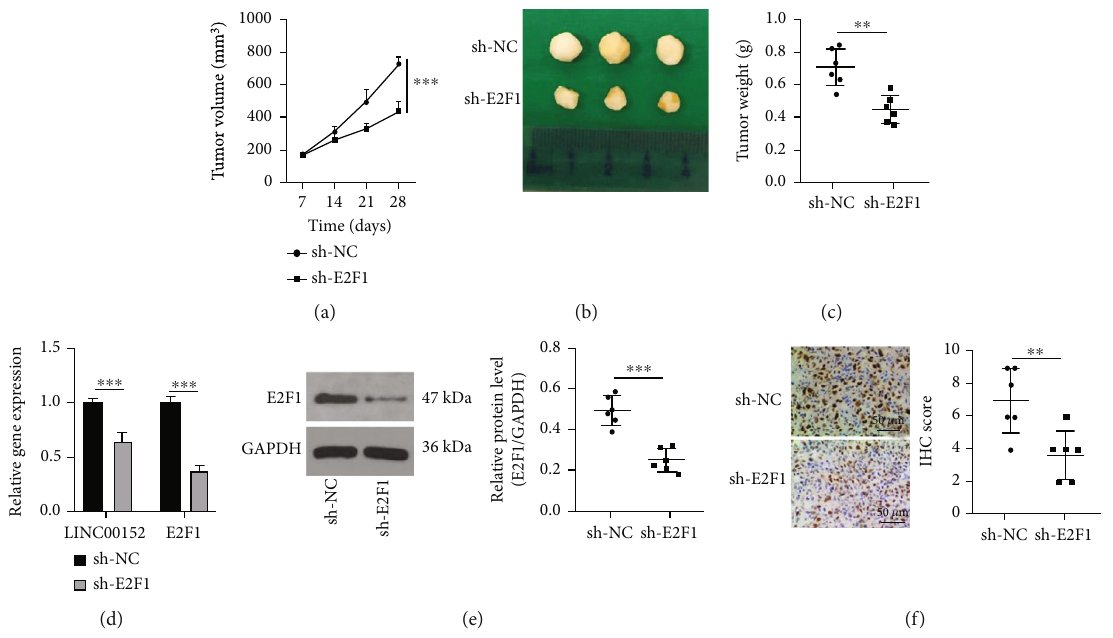
Figure 5: E2F1 knockout inhibitsPTC tumor growth in vivo . (a) Tumor volume assessment. (b) Images of transplanted tumors in nudemice. (c) Weights of transplanted tumor in nude mice. (d) Expression patterns of LINC00152 and E2F1 mRNA detected by RT-qPCR. (e) Level of E2F1 protein veri fi ed through Western blot analysis. (f) Ki67 positive expression patterns measured by immunohistochemical staining. N = 6 . Data are expressed as mean ± standarddeviation . The t -test was used for pairwise comparison. ∗∗ p < 0 : 01 ; ∗∗∗ p < 0 : 001